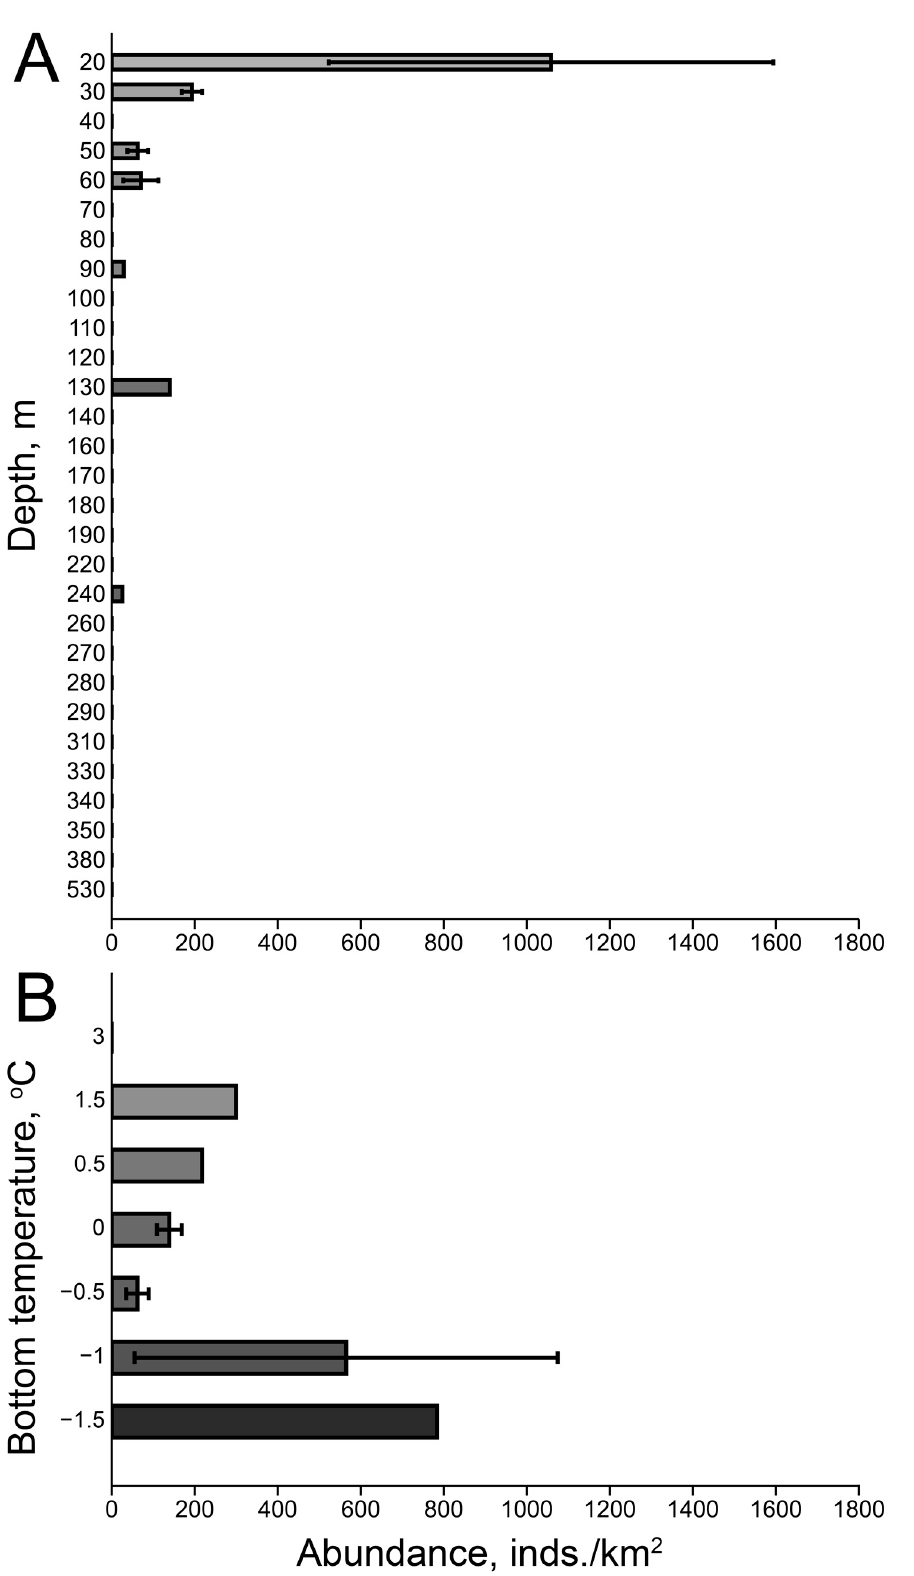
Figure 3. Bar chart for ribbed sculpin Triglops pingelii abundance (inds./km 2 ) mean values relative to depth ( A ) and bottom temperature ( B ). Whiskers, where available, represent the standard error of mean. Whisker length is one